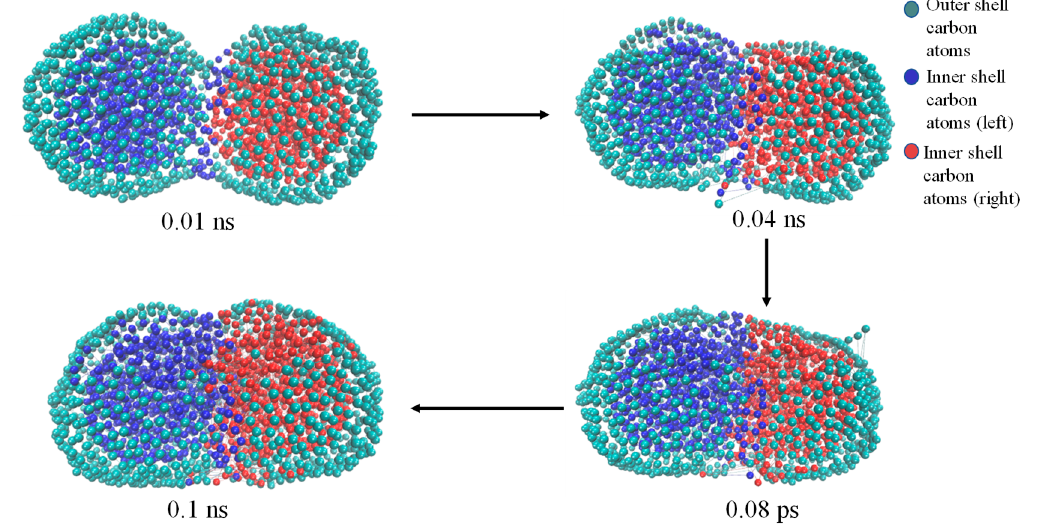
Figure 19. Atomistic model of carbon shell evolution at 3327 °C.